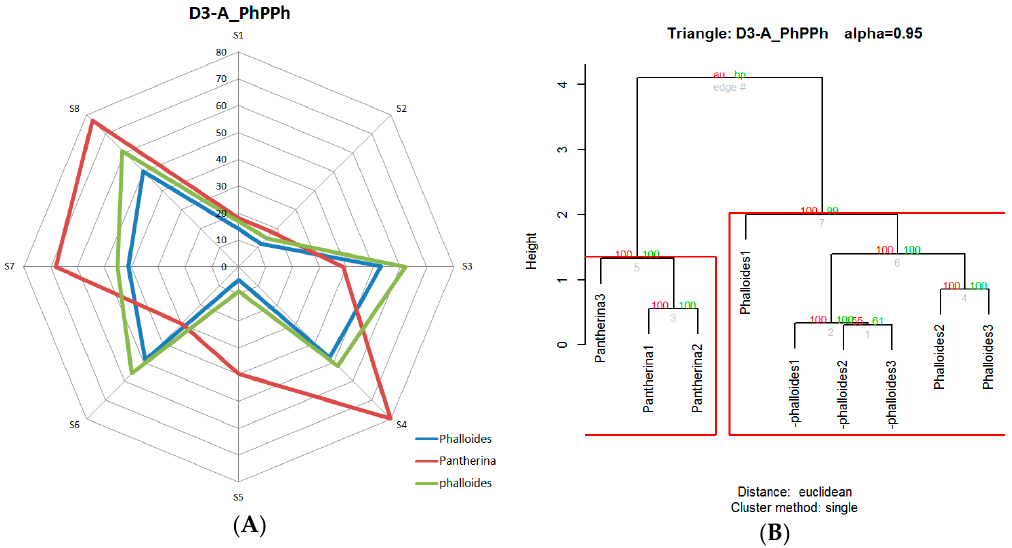
Figure 9. Radial graph ( A ) and grouping dendrogram ( B ) of triangle D3-A_PhPPh.